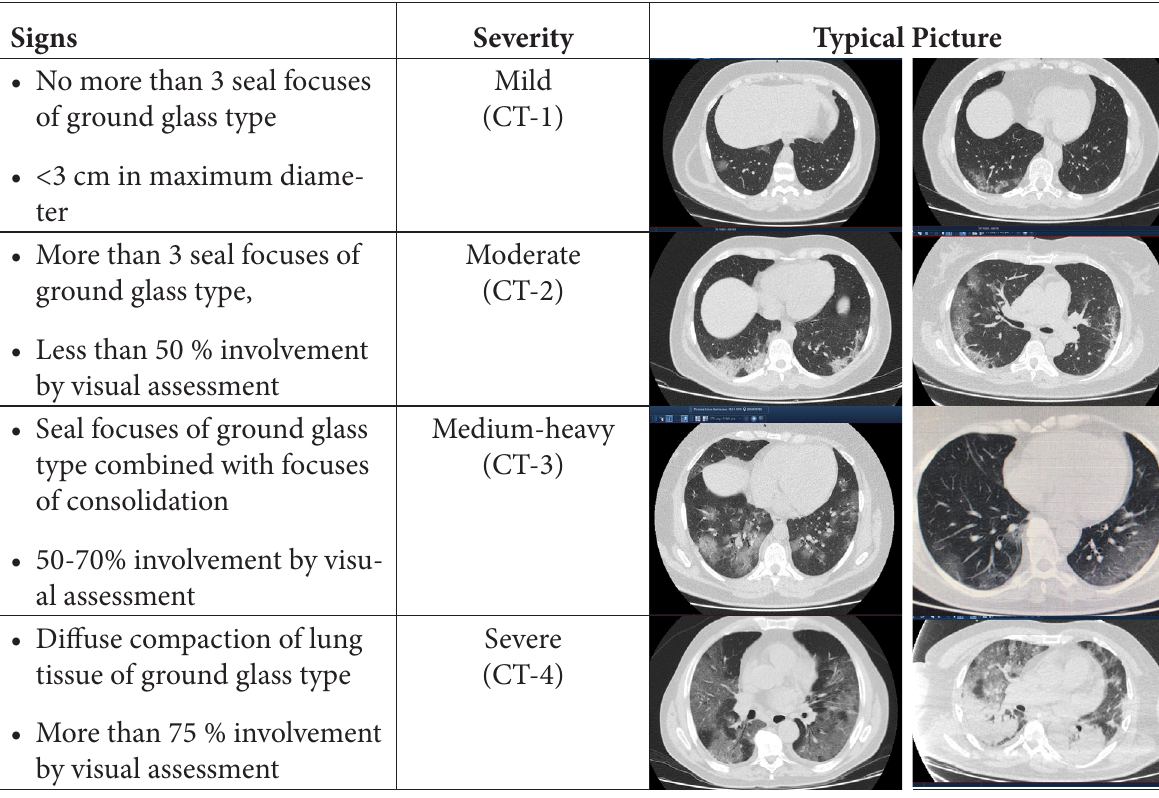
Figure 1. Clinical assessment of pneumonia severity based on computed tomography (CT) scores. Scoring method: Mild (CT-1)—no more than three ground-glass opacities of <3 cm maximum diameter. Moderate (CT-2)—more than three ground-glass opacities; less than 50% involvement by visual assessment. Medium-heavy (CT-3)—ground-glass opacities and pulmonary consolidation; 50- 70% involvement by visual assessment. Severe (CT-4)—diffuse ground-glass opacities with or without consolidation; more than 75% involvement by visual